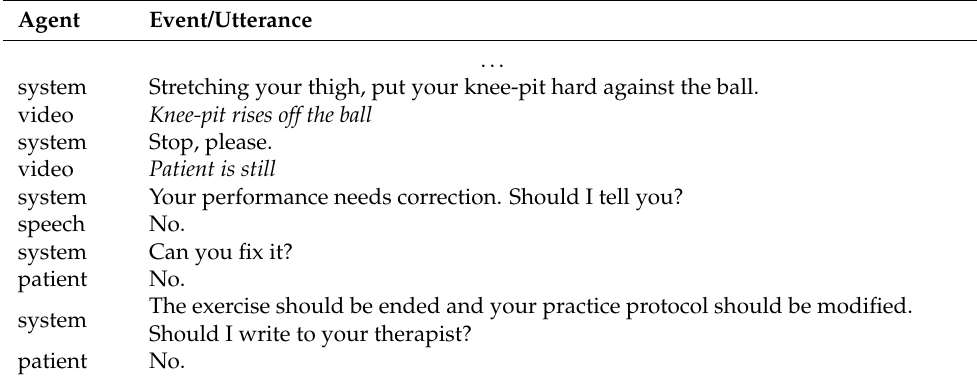
Table 3. Rule-based interaction. In this example, the system detects an error. Note that the patient may indicate that they are aware of it and choose not to inform the